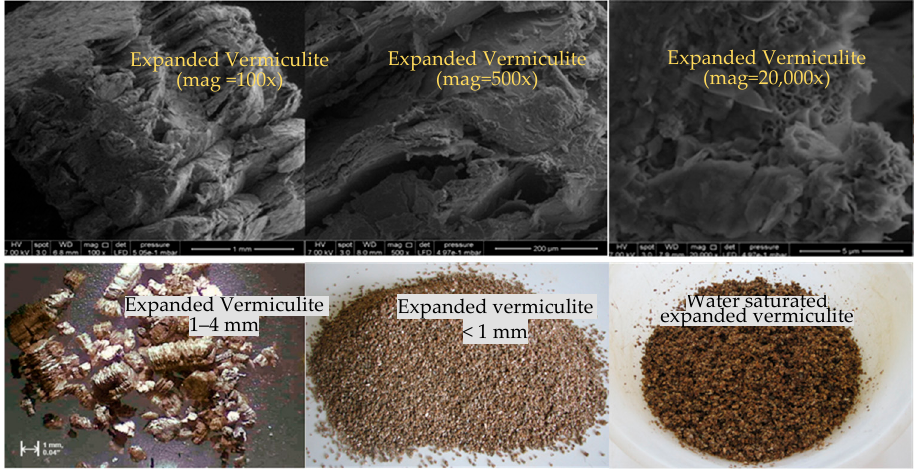
Figure 1. SEM images of expanded vermiculite and the form before use in the mixture .